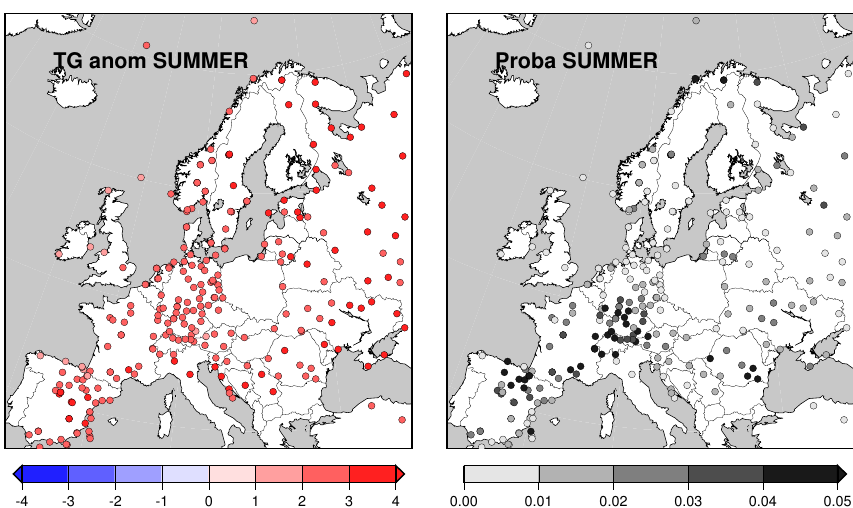
Fig. 6. Left panel: observed mean summer (June to August: JJA) temperature anomaly (in ◦ C) in Europe for the 6 hottest summers be- tween 1948 and 2012 (upper 90th quantile of mean JJA temperature). Right panel: probability of exceeding the 90th quantile of mean JJA temperature in 100 simulations of the “dynamic” weather